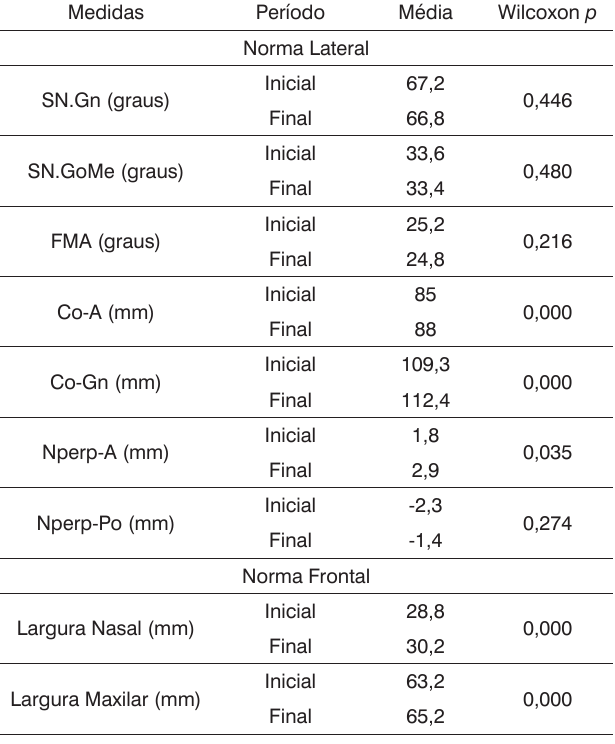
Tabela 2. Médias Iniciais X Finais do grupo controle (n = 20). Tabela 3. Médias Iniciais X Finais do grupo 2 A (n = 16).